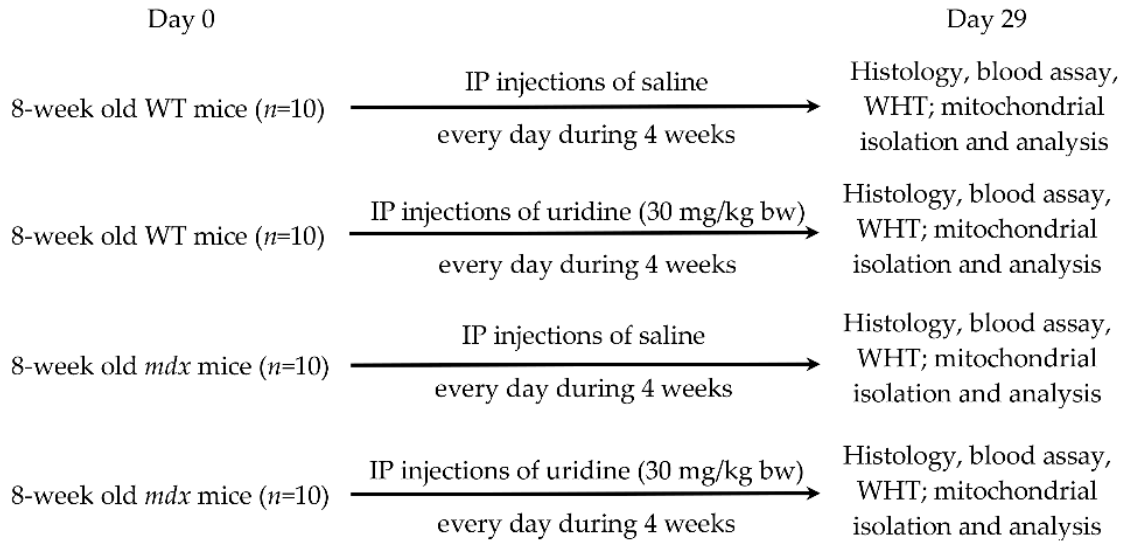
Figure 1. The experimental protocol of the study. IP: intraperitoneal; WHT: wire hanging test.